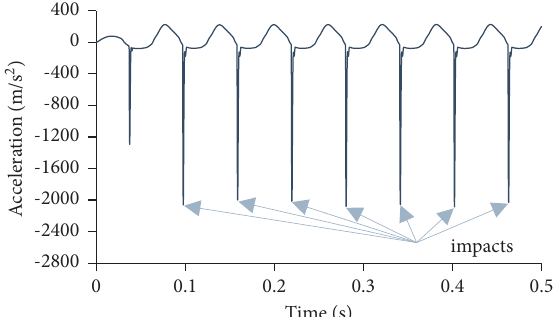
Figure 6: Acceleration curve of impact